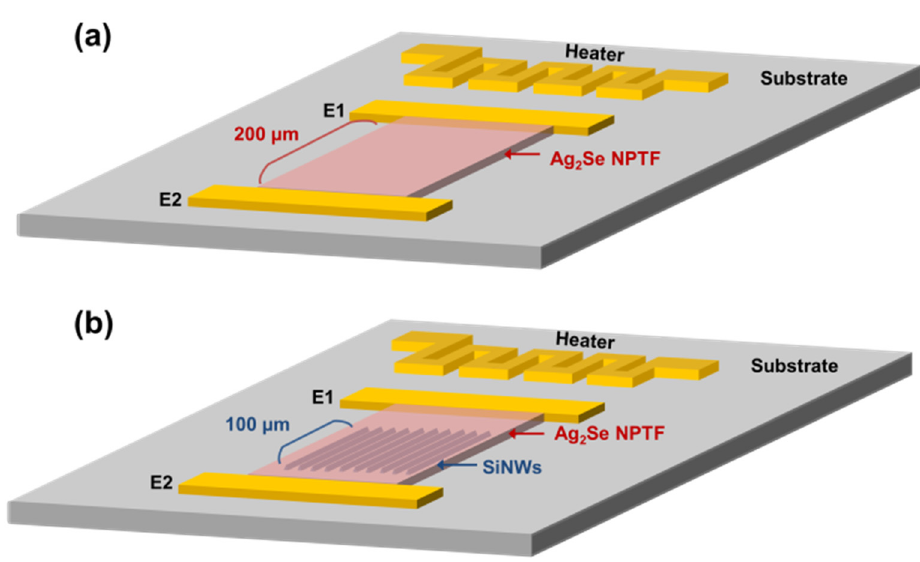
Figure 1. Schematic of a thermoelectric platform comprising a meander line patterned heater, two electrodes (E1, E2), and thermoelectric channels of ( a ) the Ag 2 Se nanoparticle thin film (NPTF) alone and ( b ) the Ag 2 Se NPTF embedded with silicon nanowires (SiNWs).